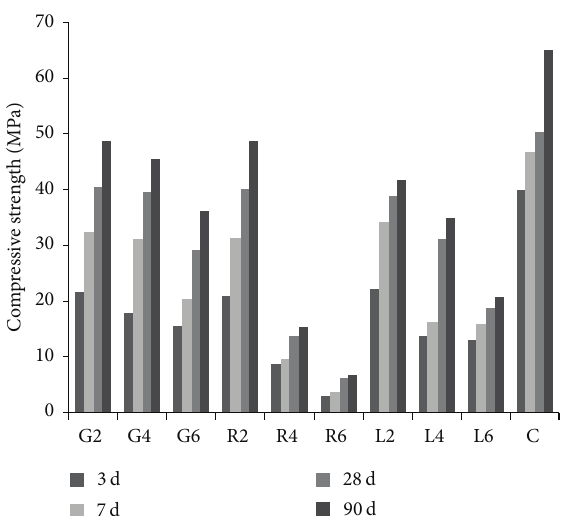
Figure 4: Compressive strength of mortars with water-binder ratio of 0.3.